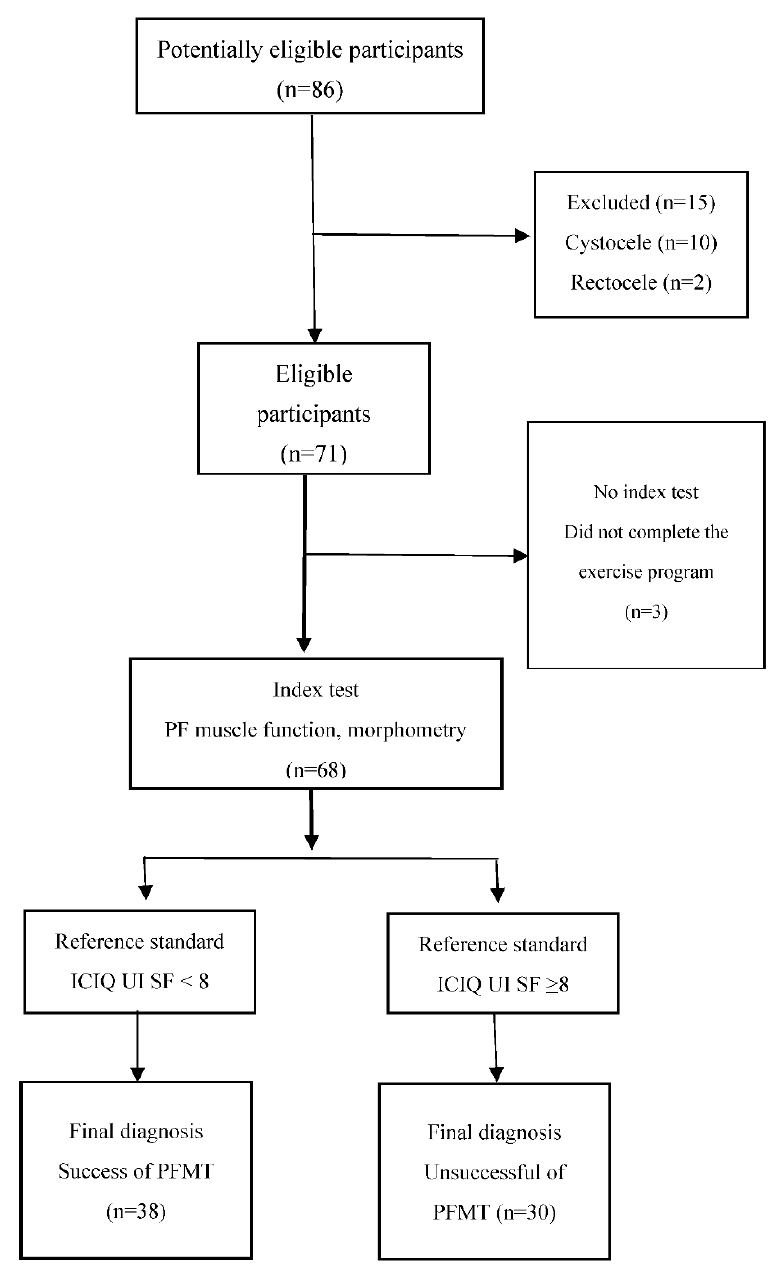
Figure 1. STARD diagram.